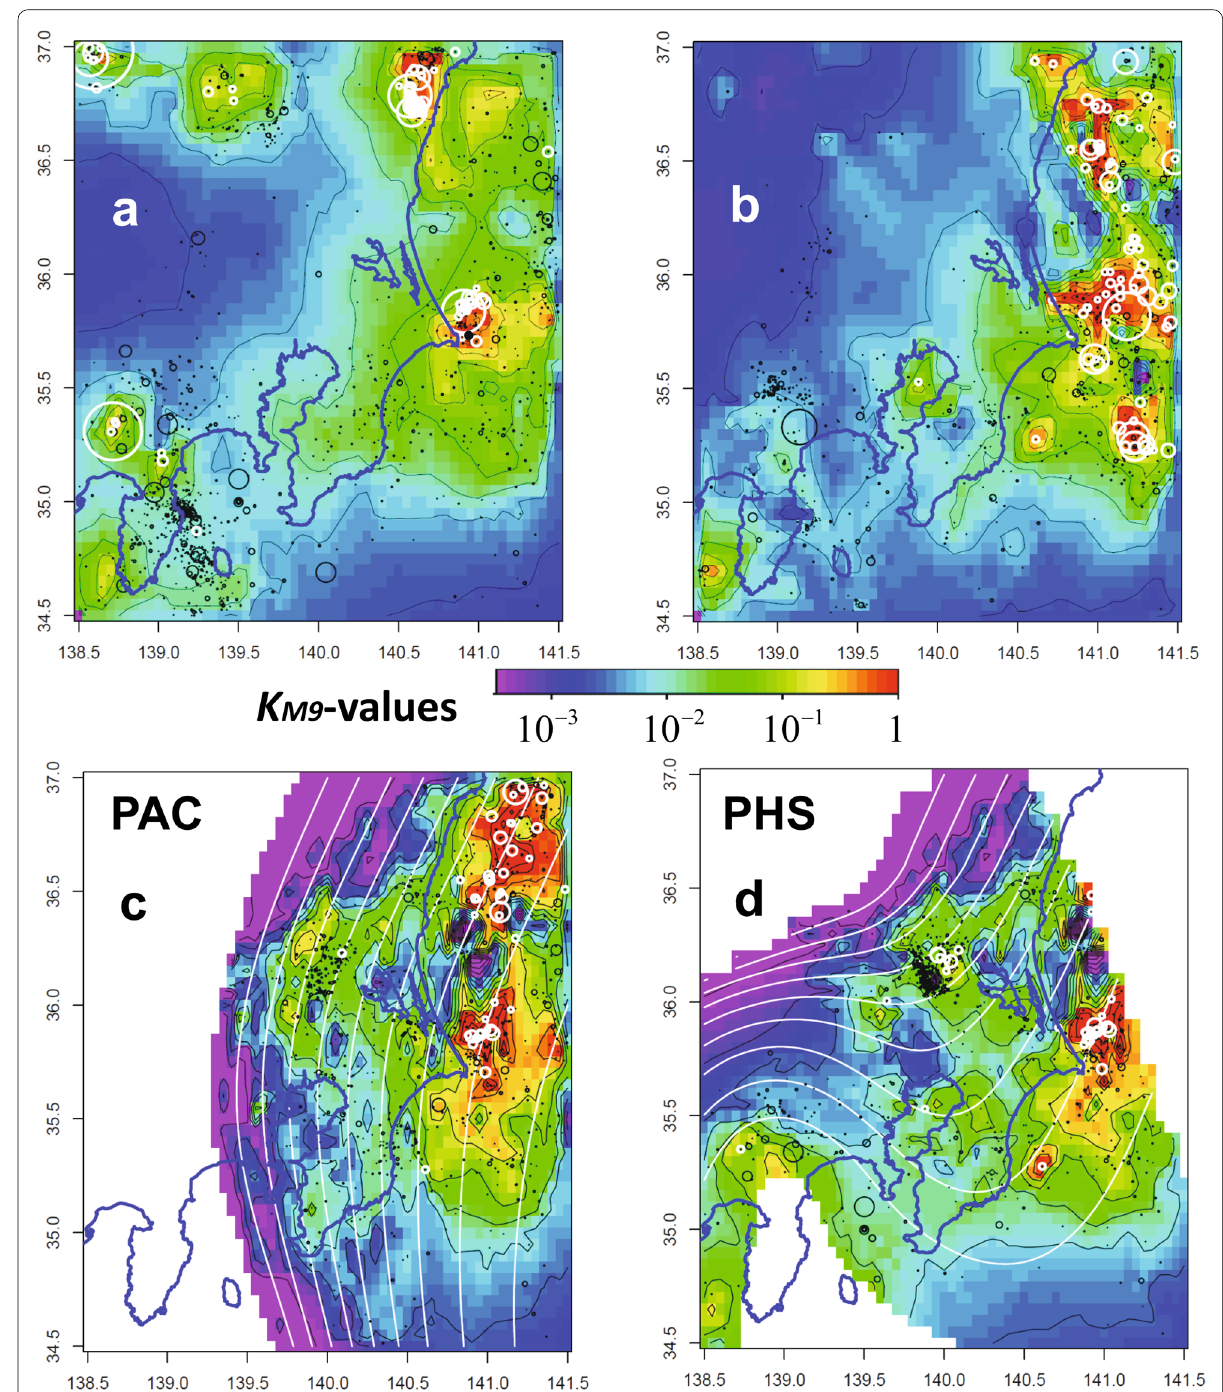
Fig. 6 Sectional images of K M9 -values. The units of the log-scale color legend correspond to the reference value ¯ K M 9 in Table 1 (Reference). Small black circles and dots are the earthquakes of M4 and larger, that occurred near each plane and plate surface, throughout the entire period 1923– 2015. White circles are the earthquakes of M4 and larger, that occurred within the month right after the M9 event. Both black and white markers increase in size with event magnitude: the white circles are five times larger than the black marks for events of the same magnitude. The depth ranges used in plotting the both disks circles are the same as those in the Fig. 4